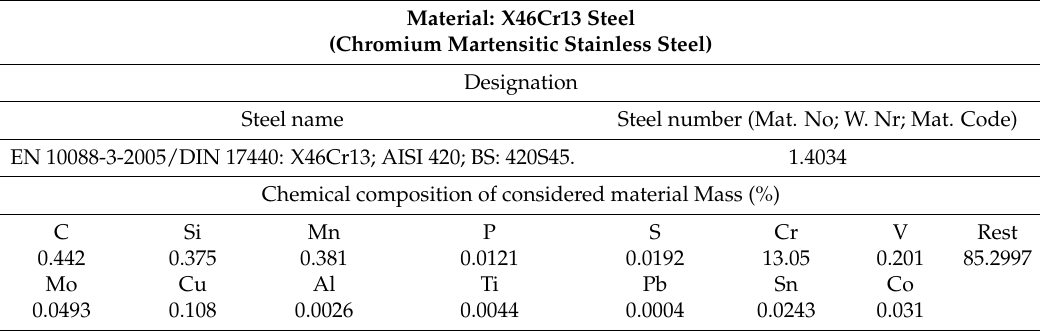
Table 1. Material chemical composition: X46Cr13